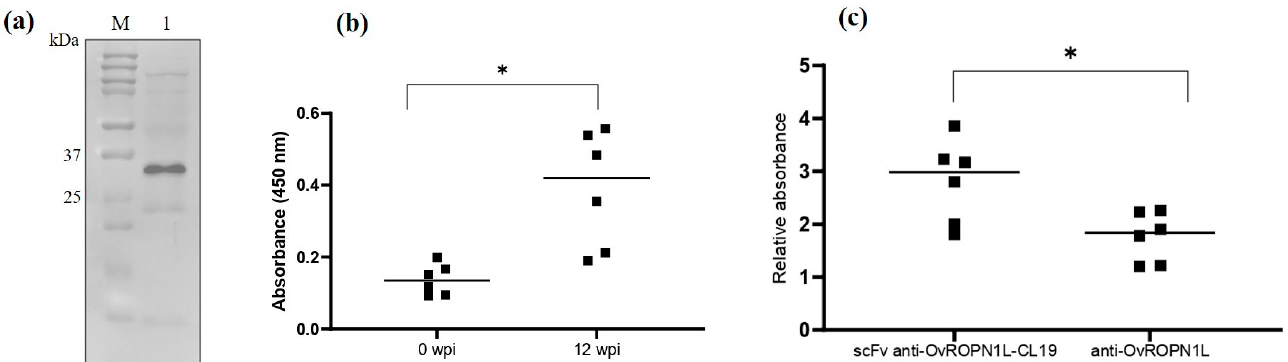
Figure 3. ( a ) Purified scFv anti - OvROPN1L - CL19 at the predicted molecular weight ( 26–28 kDa )